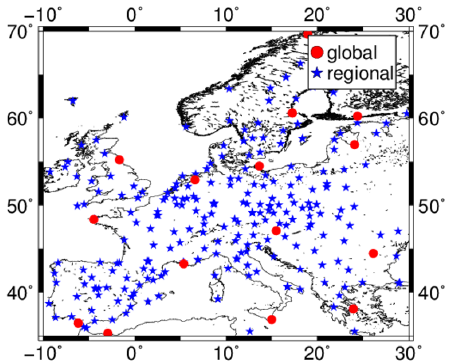
Figure 6. Receiver stations providing observations for the global data set D 1 (red dots) and stations providing observations for the regional data set D 2 (blue) within the European